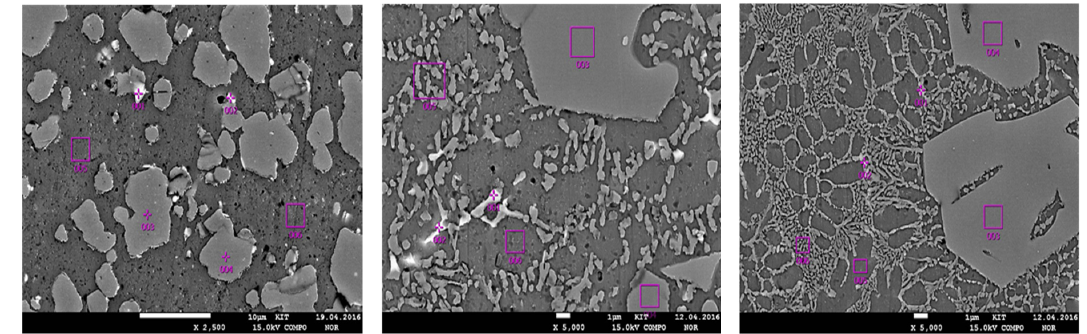
Figure 5. EDX investigation of phases in S220: Left : base material; Middle : welding speed 0.5 m/min; Right : welding speed 10 m/min.